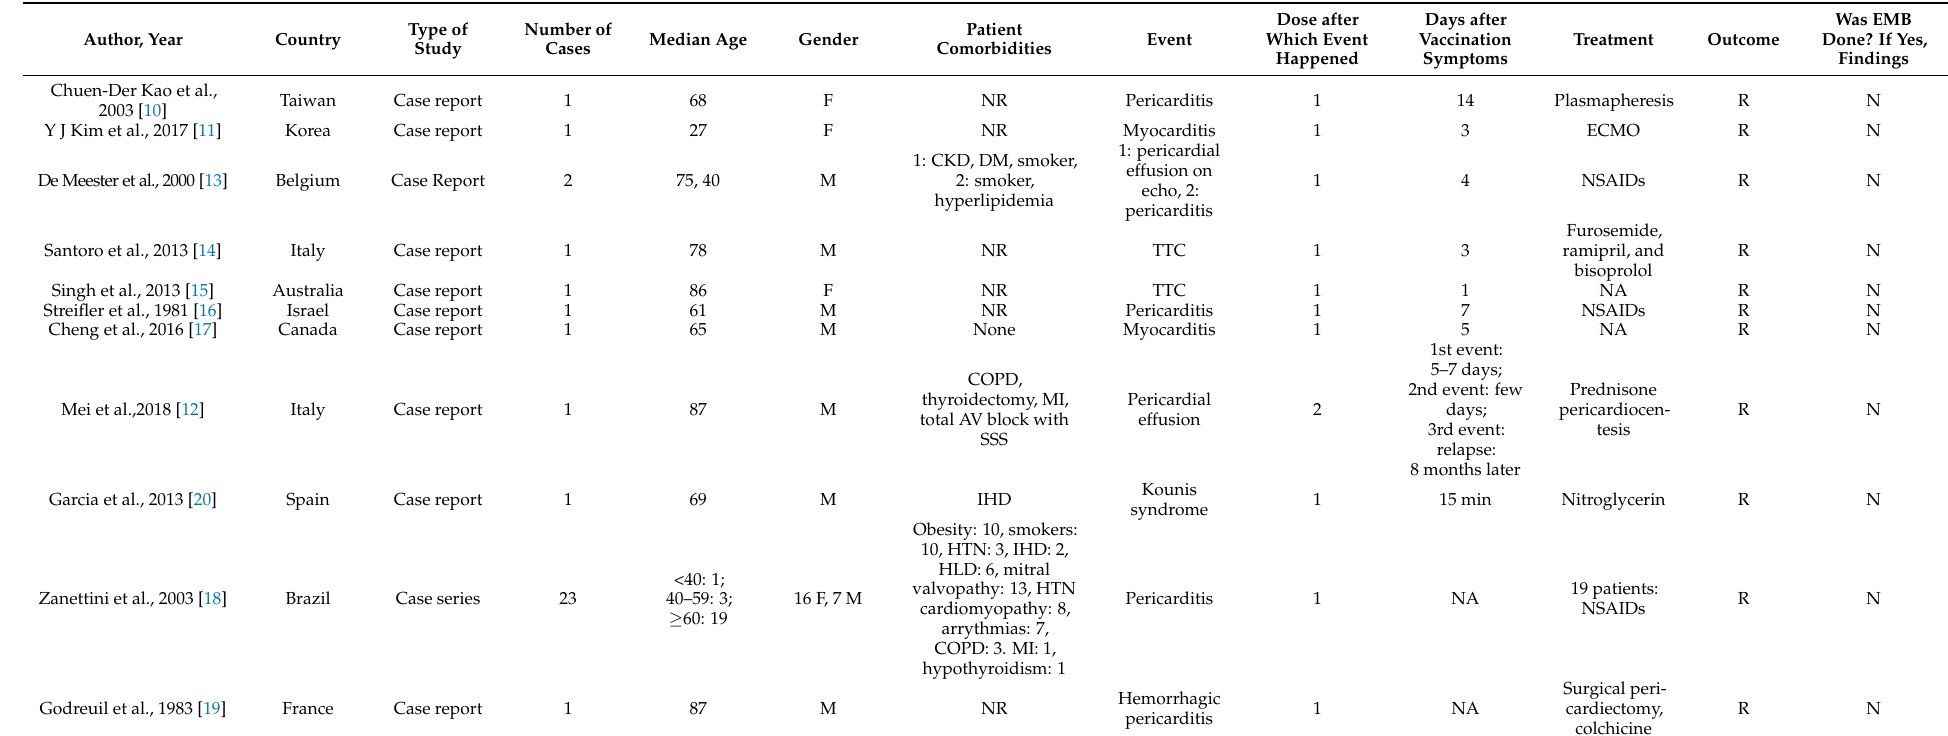
Table 2. Adverse events after Influenza